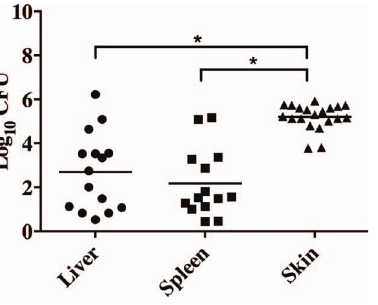
Figure 1. GAS strain 5448 dissemination from skin to deep tissue. Analysis of bacterial loads in liver, spleen, and skin wound tissue. C57Bl/6[hPg(Tg)] mice were injected with a dose of , 1– 2 6 10 8 CFU/100 m l of 5448 WT-5448/CovR + S + . At 3 days post-infection, organs were harvested and bacterial counts obtained from serial dilutions of homogenized tissues. Asterisks indicate statistical signifi- cance determined by unpaired two-tailed students t-test, P , 0.001.